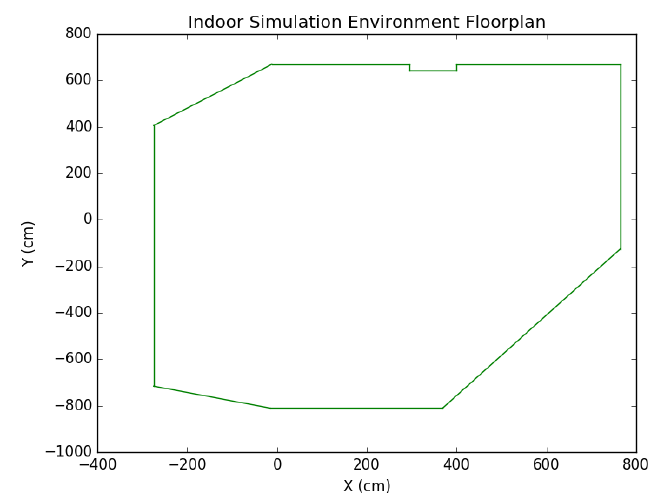
Figure 18. Indoor simulation environment